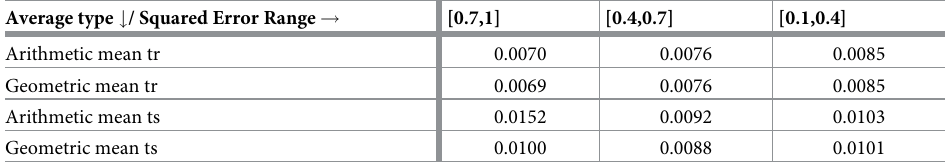
Table 4. Arithmetic and geometric mean obtained from the sum of the squared error in 20 implementation of ANN-PSO network in three ranges of [0.1, 0.4], [0.4, 0.7], [0.7, 1].